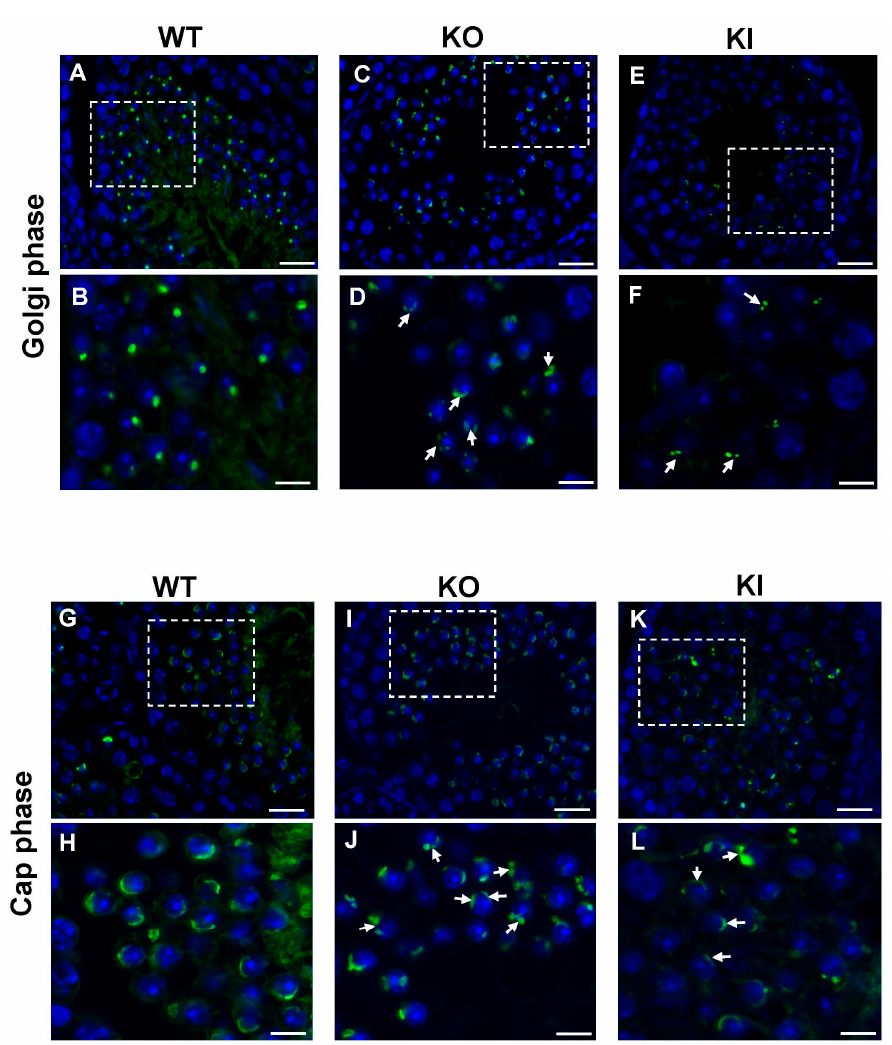
Figure 6. Immunofluorescence detection of developing acrosome in RS of adult mice testis sections using FITC-PNA staining. PNA staining in WT RS in the Golgi phase shows homogenous FITC signal (green) in single acrosome vesicle ( A , B ), while RS from both KO and KI mice have a diffuse pattern with more than one acrosome vesicle ( C – F ). In the cap phase, WT RSs display the characteristic thin layer of acrosomal caps ( G , H ) while KO and KI spermatids have a punctate PNA staining indicating fragmented acrosomal structure ( I – L ). DAPI (blue) was used for nuclear staining. Arrows indicate abnormal acrosomes. Lower-magnification images were taken at 60×. Dotted regions in the images were shown at higher magnification taken at 100× oil immersion. Scale bar for low-magnification images is 50 μ m and for high-magnification images is 10 μ m.